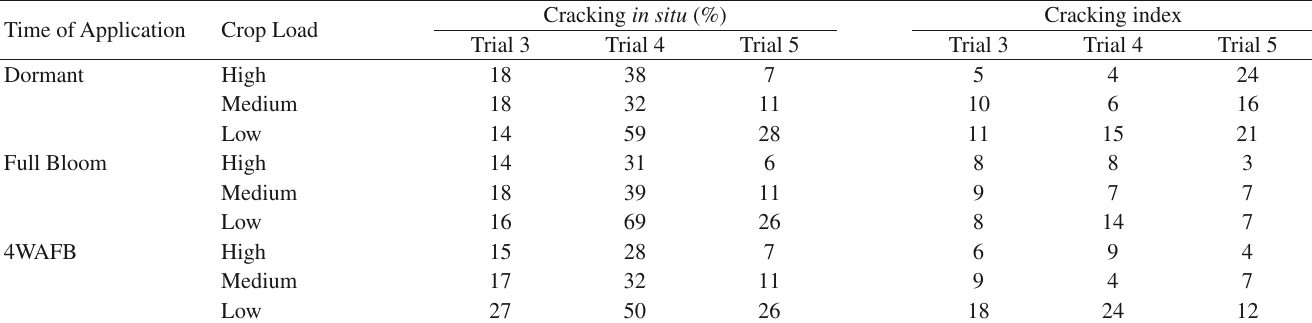
Table 2 - Cracking index (n = 50) determined for fruit from the three manipulated crop load trials (Trials 3, 4 and 5) Time of Application Crop Load